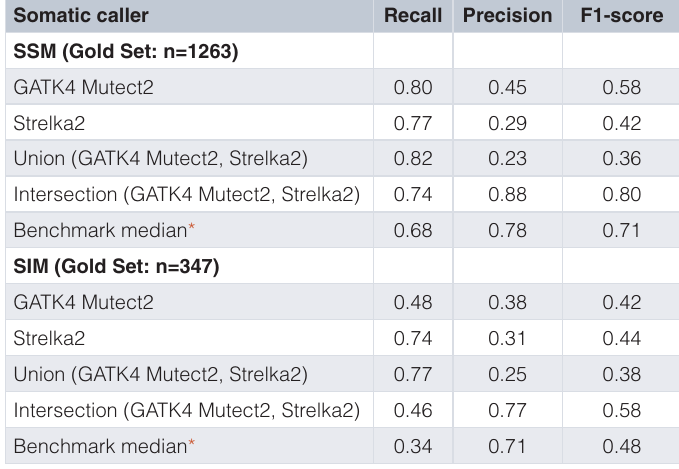
Table 3. Sarek WGS somatic variant benchmarking. Summary of accuracy measures for the two somatic variant callers used in Sarek to detect somatic single-base mutations (SSMs) and somatic insertion/deletion mutations (SIMs), as well as their union and intersection. Somatic